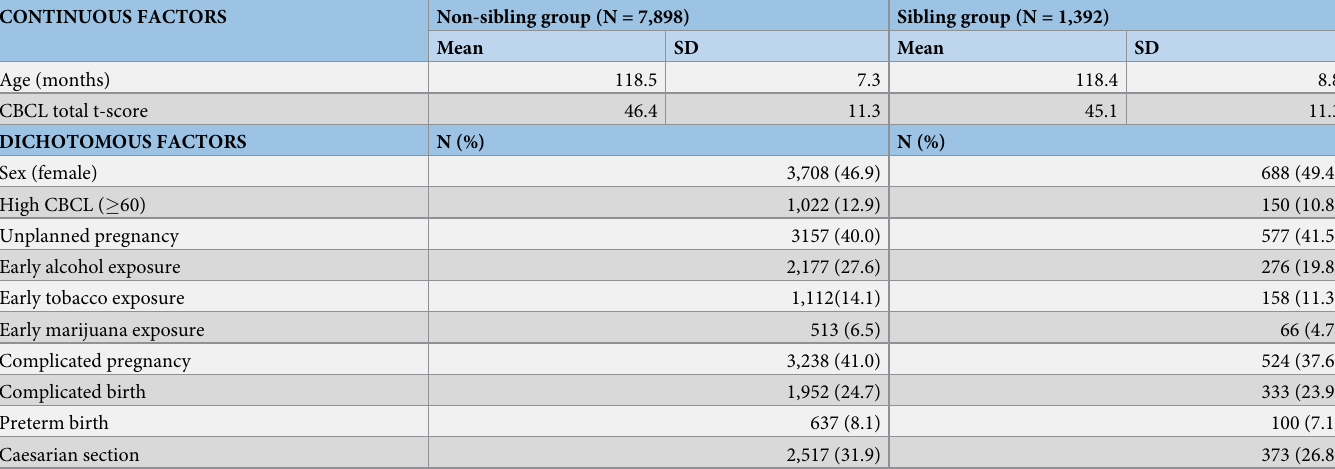
Table 1. Characteristics of non-sibling and sibling